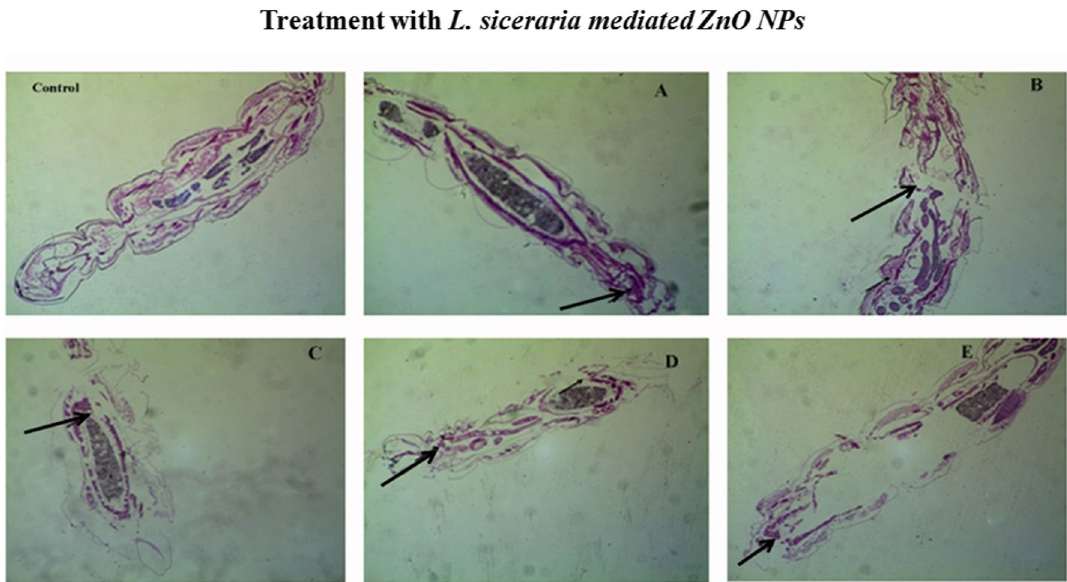
Figure 2. Histopathological images of third instar larvae of An. Stephensi treated with: ( A ) 30 ppm of L. siceraria mediated ZnO NPs; ( B ) 60 ppm L. siceraria mediated ZnO NPs; ( C ) 90 ppm of L. siceraria mediated ZnO NPs; ( D ) 120 ppm of L. siceraria mediated ZnO NPs; ( E ) 150 ppm L. siceraria mediated ZnO NPs (arrow indicates disordered and broken epithelial cell, complete break up of midgut and caeca and collapsed larval